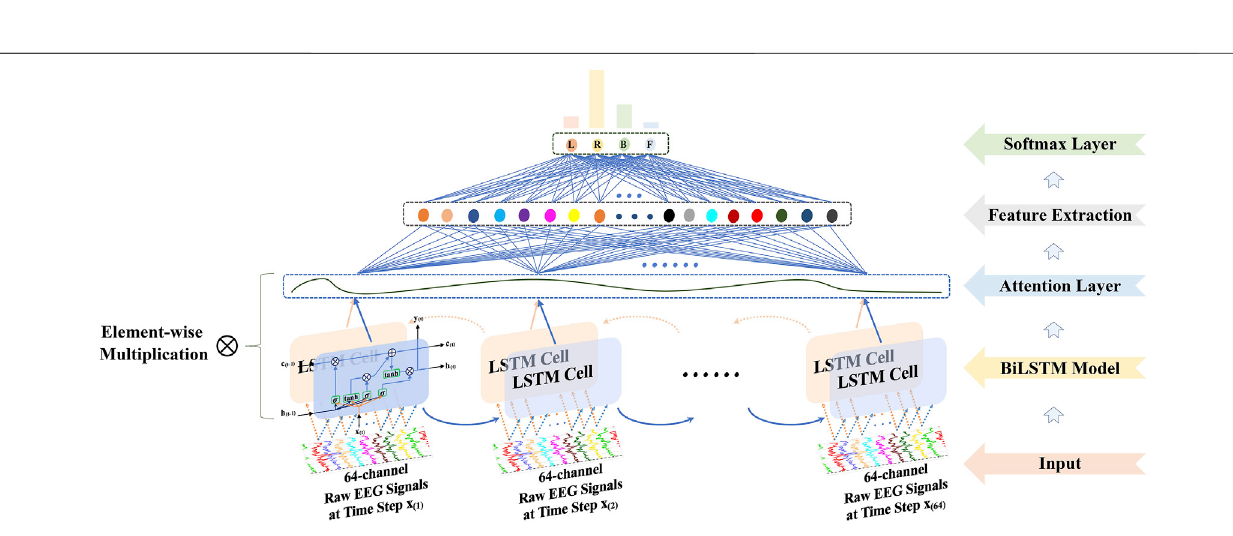
FIGURE 2 | Presented BiLSTM with the attention mechanism for feature